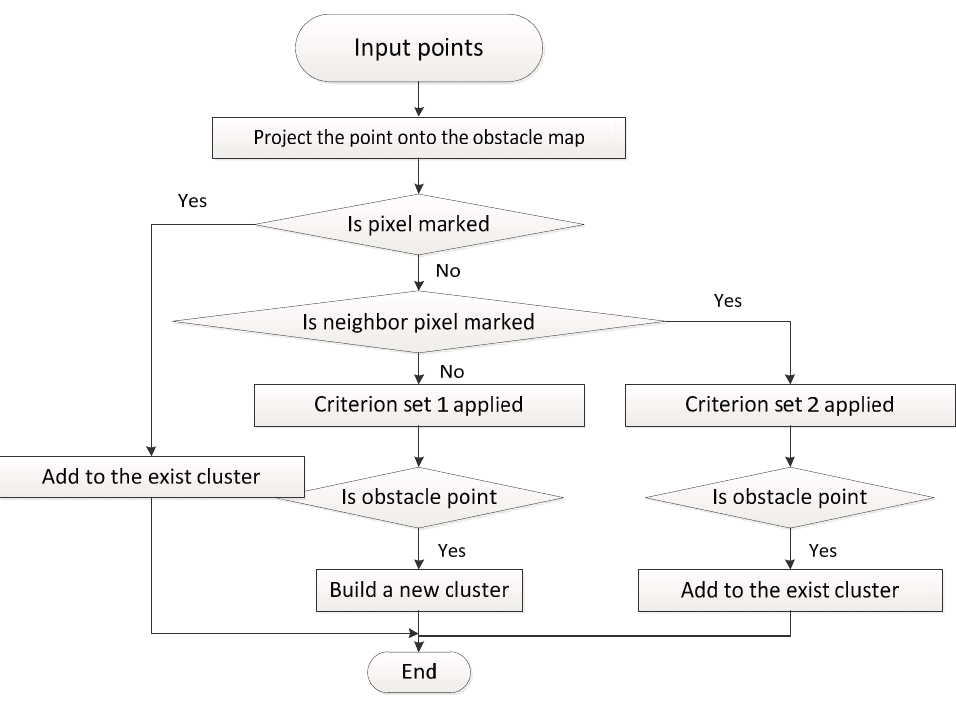
Figure 4. Process flow for